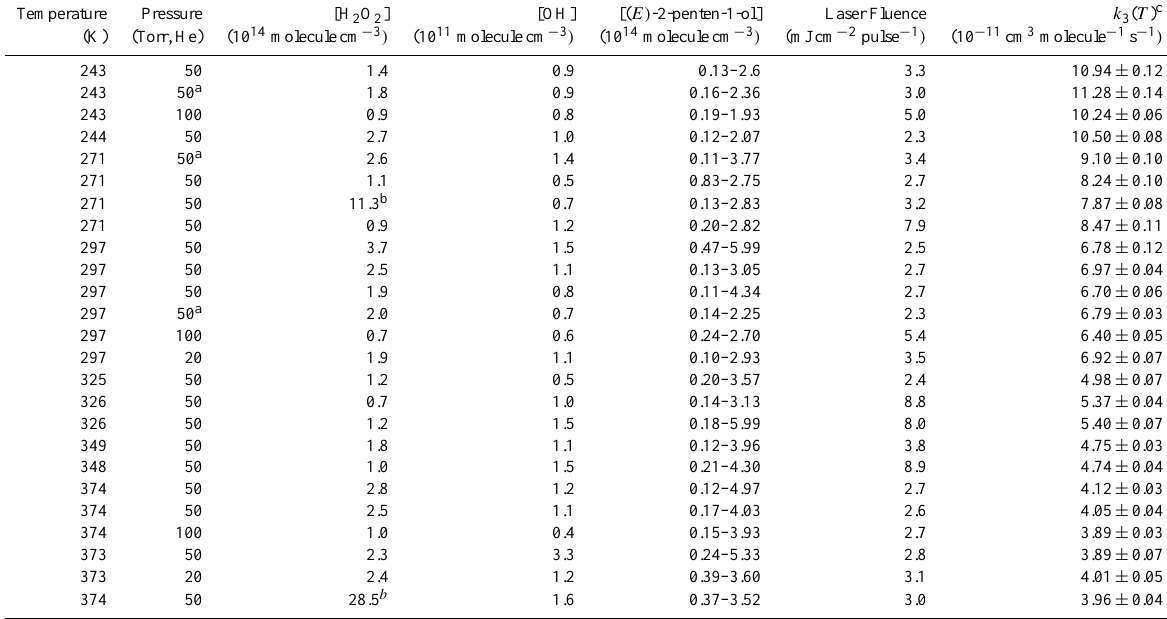
Table 4. Summary of experimental conditions and measured rate coefficients, k 3 (T ), for the OH+( E) -2-penten-1-ol reaction. Temperature Pressure